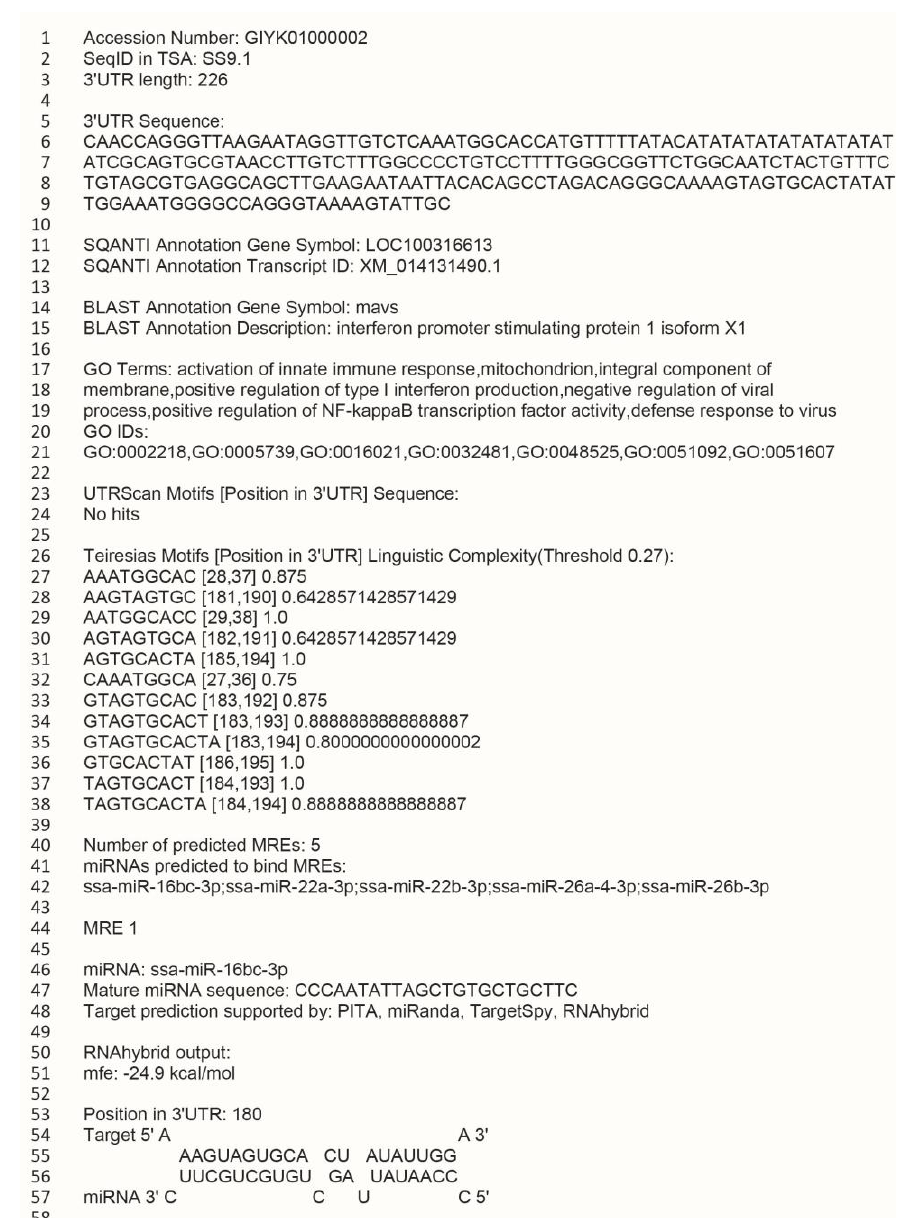
Figure 2. The simple text file output from a search using the transcript accession number as input.